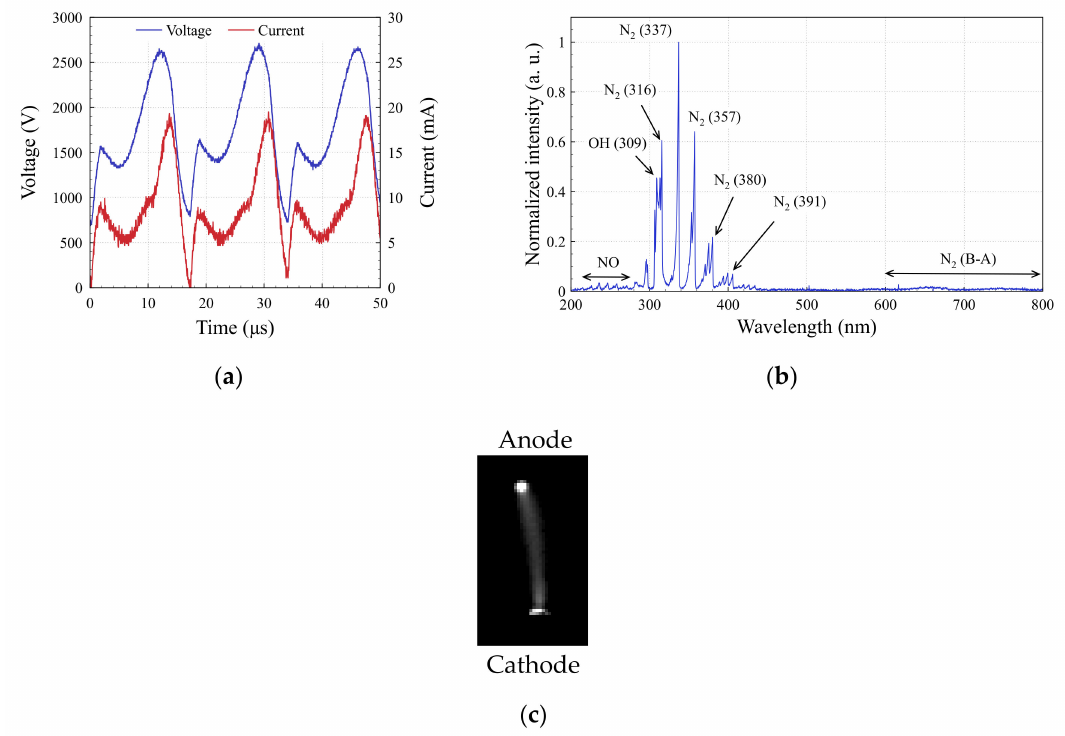
Figure 2. Typical ( a ) current and voltage waveforms, ( b ) optical emission spectrum, and ( c ) photo of plasma transferred to surface of deionized (DI)